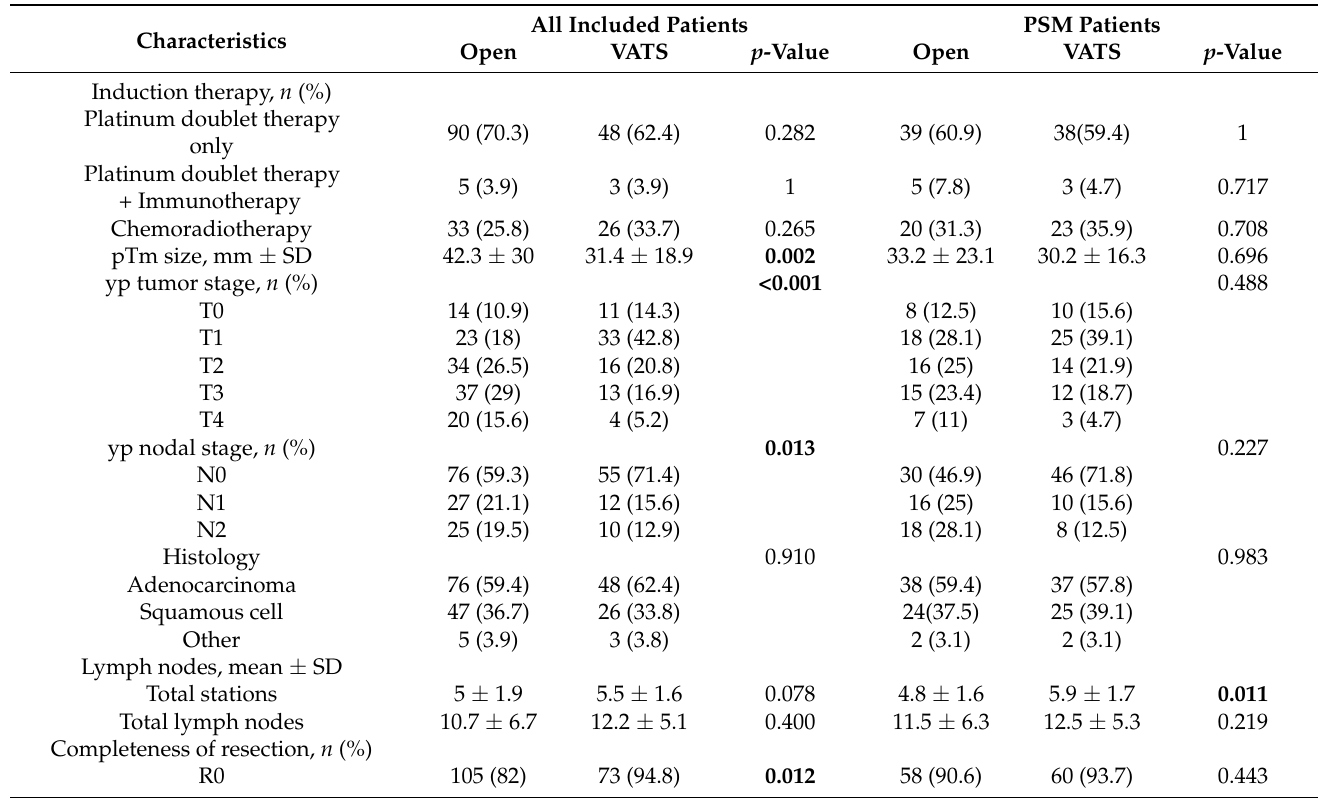
Table 2. Treatment and tumor characteristics for all included patients and PSM